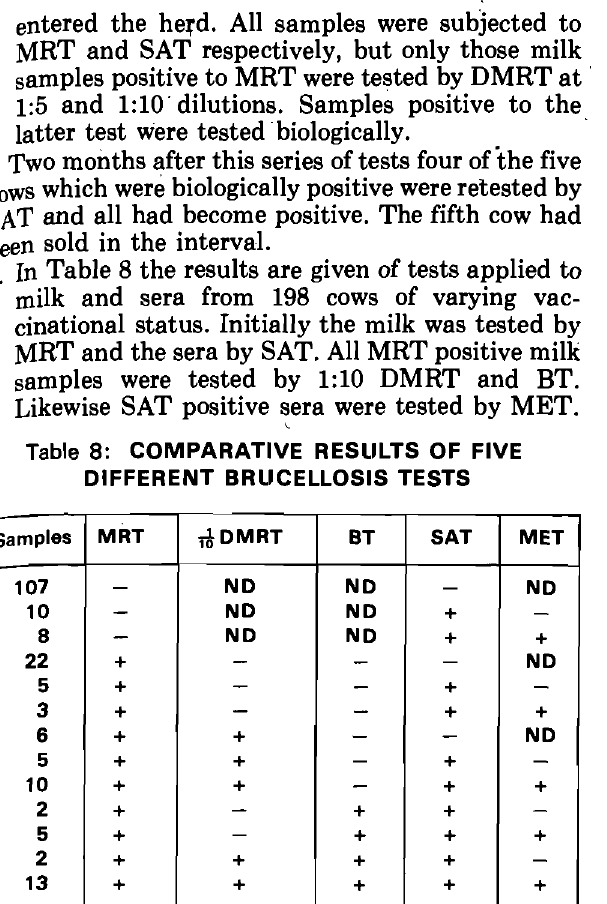
Table 8: COMPARATIVE RESULTS OF FIVE DIFFERENT BRUCELLOSIS